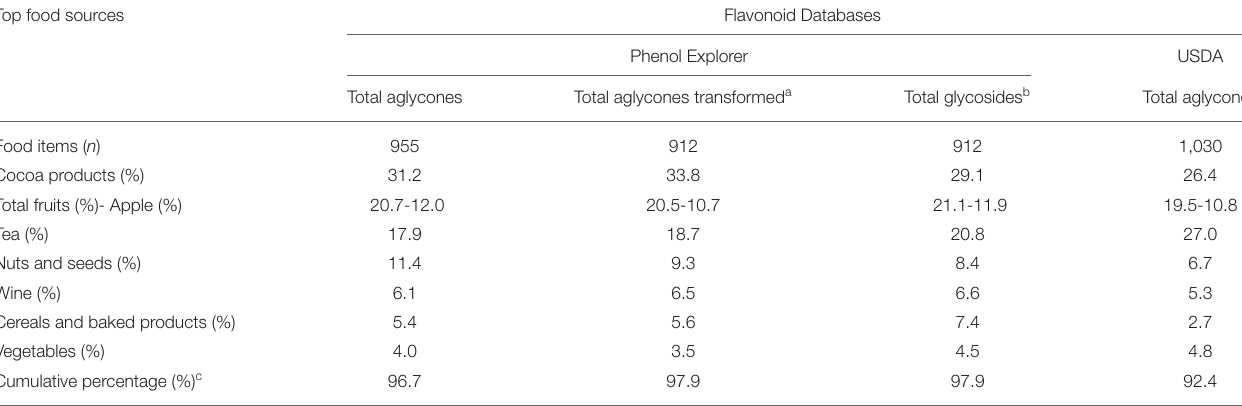
TABLE 2 | Top food sources by databases and methods used in MAX study. Top food